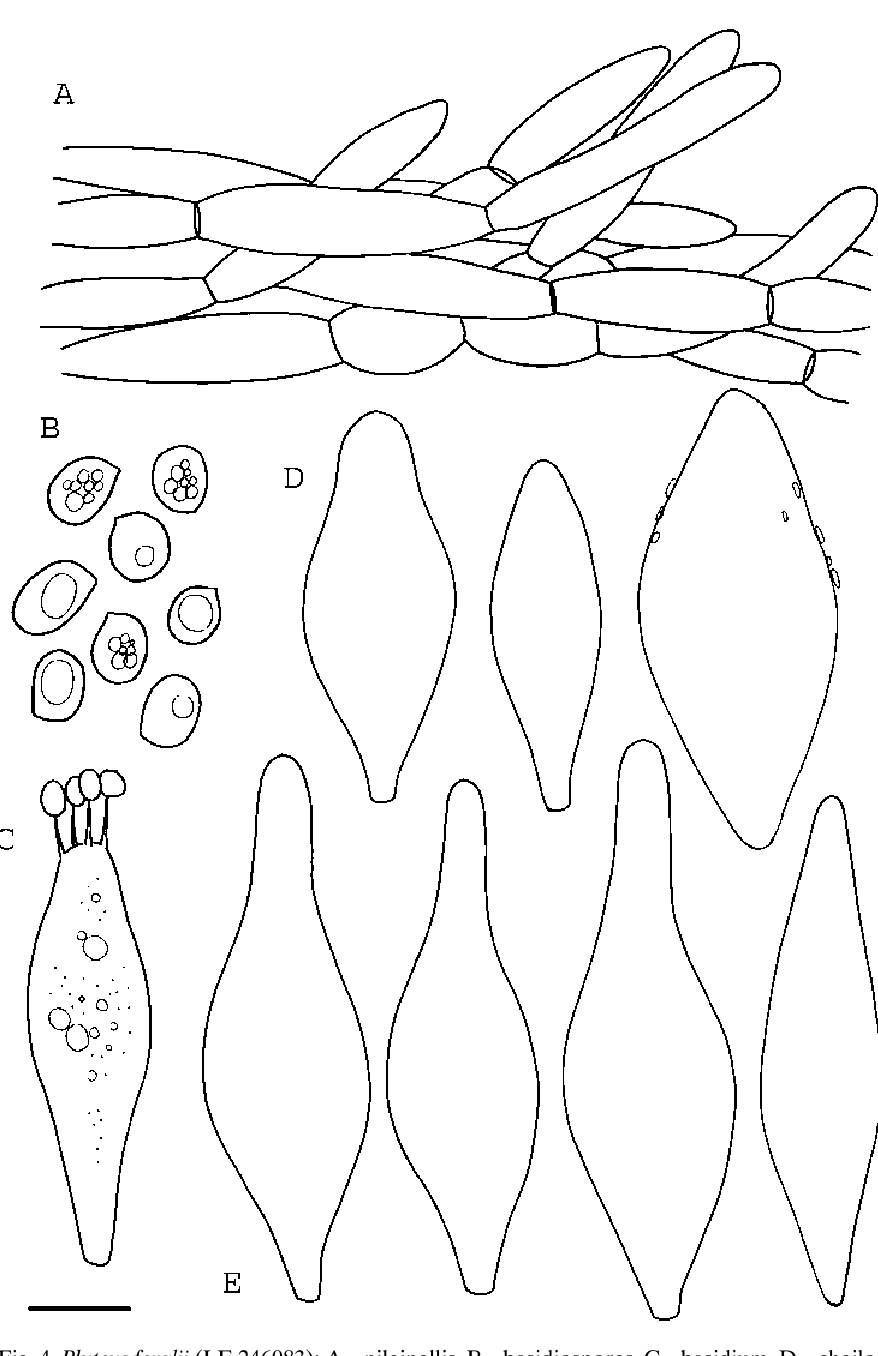
Fig. 4. Pluteus fenzlii (lE 246083): a – pileipellis, B – basidiospores, C – basidium, D – cheilo- cystidia, E – pleurocystidia; scale bars A-� = 10 μm, D-E = 15